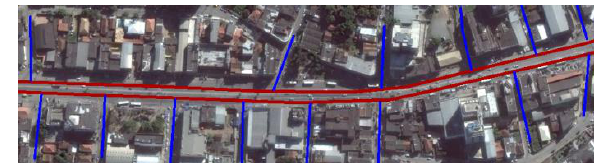
Figure 6. Main road in red and crossing streets in blue.